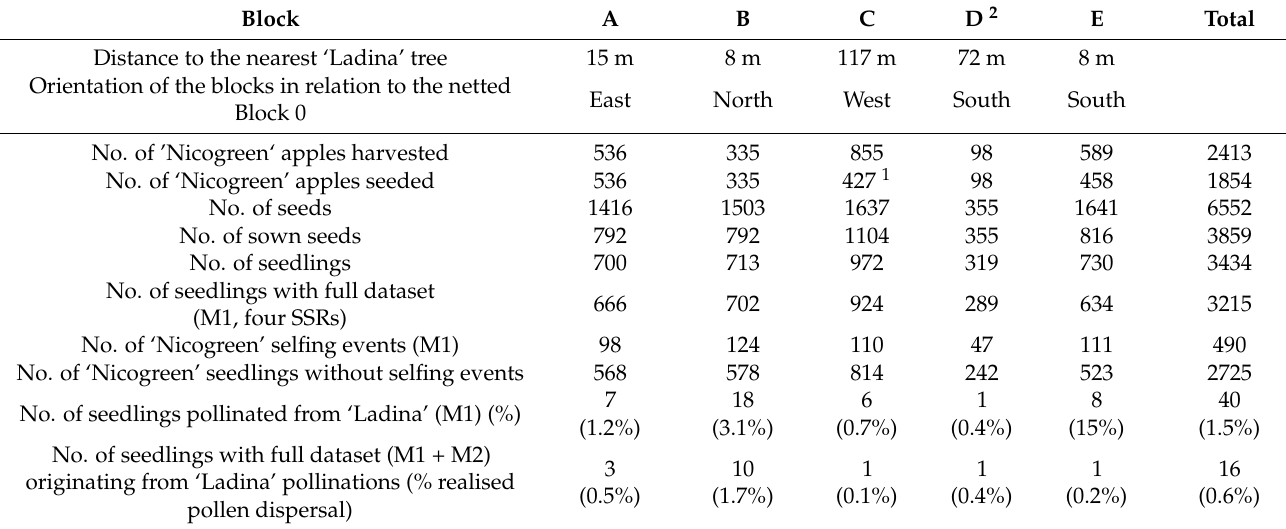
Table 2. Assessment of ‘Nicogreen’ seedlings originating from ‘Ladina’ pollination in 2018. Block A B C D 2 E Total Distance to the nearest ‘Ladina’ tree 15 m 8 m 117 m 72 m 8 m Orientation of the blocks in relation to the netted East North West South Block 0